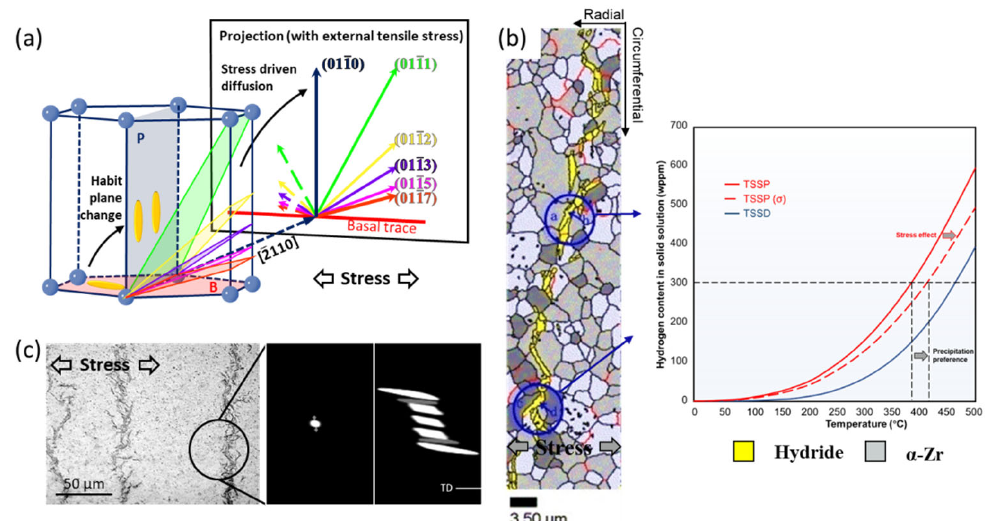
Figure 8. Mechanisms of hydride reorientation. ( a ) Stress drives hydride reorientation at microscale [66]; ( b ) change in nucleation sites when TSSP decreases under large tensile stress [114,115]; ( c ) hydride stacking perpendicular to the tensile stress [6,52]. Reprinted with permission from [66]; Copyright 2022 Elsevier. Reprinted with permission from [115]; Copyright 2006 Elsevier. Reprinted with permission from [6]; Copyright 2019 Elsevier. Reprinted with permission from [52]; Copyright 2019 Elsevier.